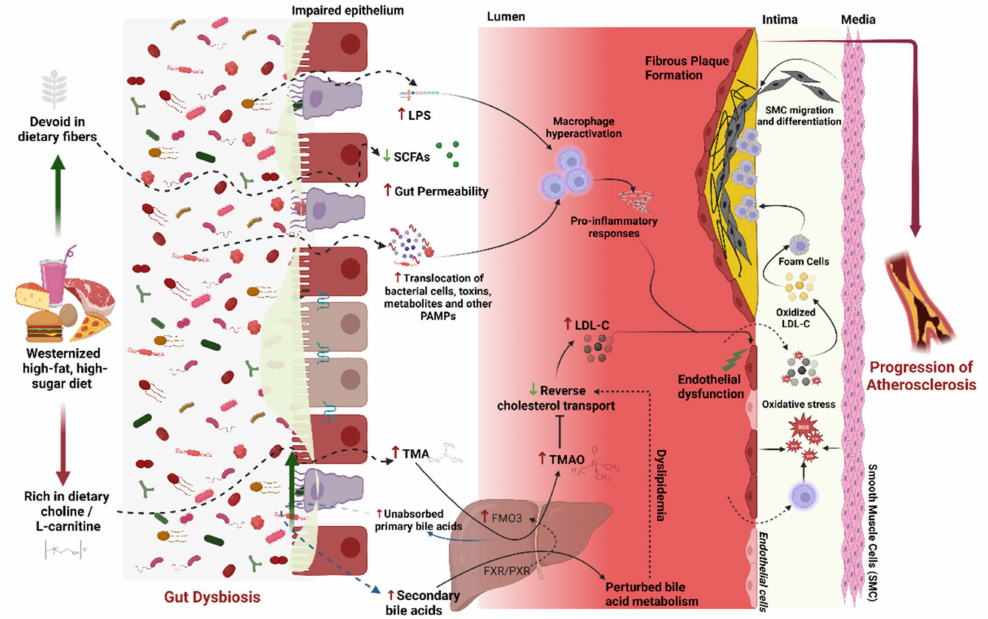
Figure 1. An overview of mechanisms and pathways via which the gut microbiome and its interaction with the host diet contribute to the pathophysiology of atherosclerosis. Intake of a westernized diet high in saturated fats and sugars instigates gut dysbiosis, which in turn triggers a cascade of various host metabolic pathways via the gut-liver-heart axis, eventually converging into atherosclerosis progression. Lack of fiber in these diets further lowers the production of microbiome-derived SCFAs leading to impaired gut epithelial permeability and translocation of microbes or their cell fragments (e.g., LPS), harmful metabolites, and PAMPs, which may provoke macrophages leading to excessive pro-inflammatory responses. On the other end, diets rich in choline/L-carnitine foster